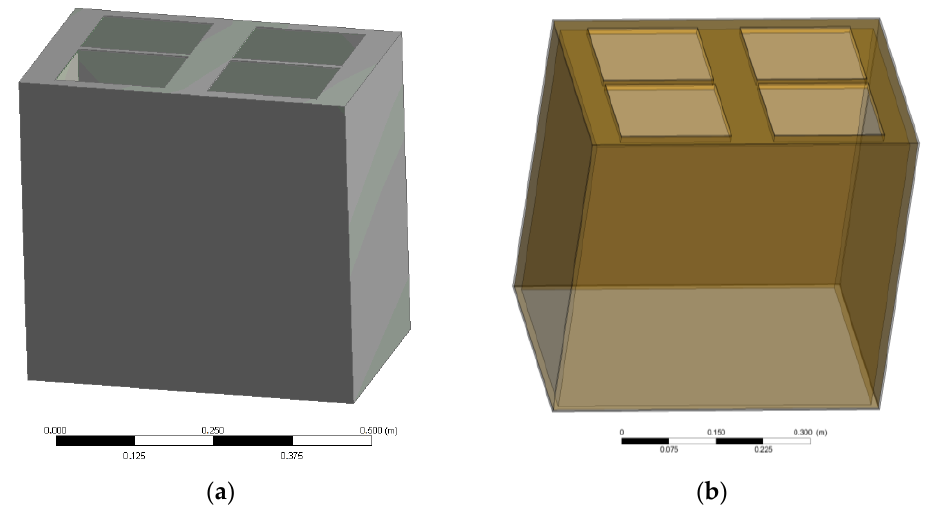
Figure 2. Modelled structure: ( a ) general view; and ( b ) wireframe view illustrating the double wall design.